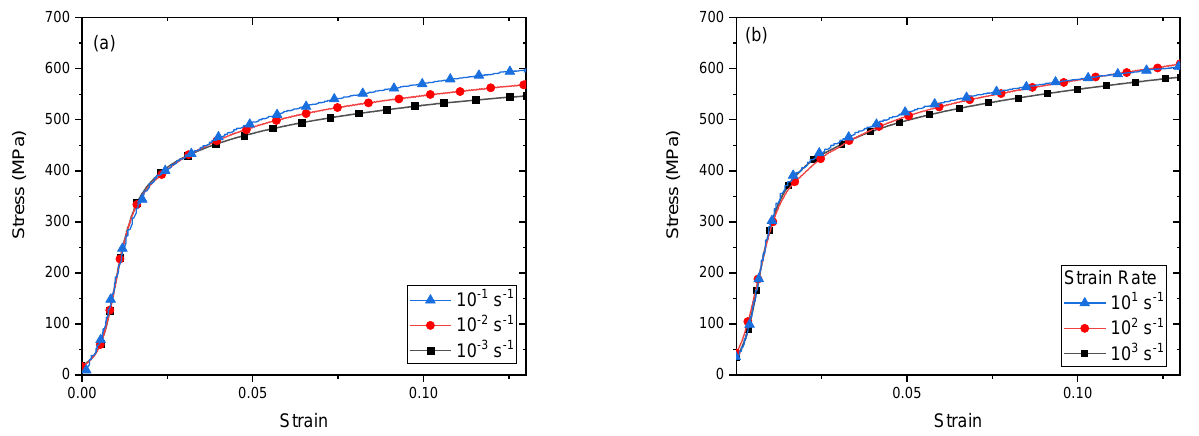
Figure 7. Experimental compression stress-strain curves of Cu50Ta consolidated at 300 ◦ C tested at strain rates of 10 − 3 , 10 − 2 , 10 − 1 , s − 1 along the extrusion direction (ED). ( a ) By route 4E, and ( b ) by route 4Bc. Table 3. Summary of compression test results on Cu-Ta composites processed by routes 4E and 4Bc.